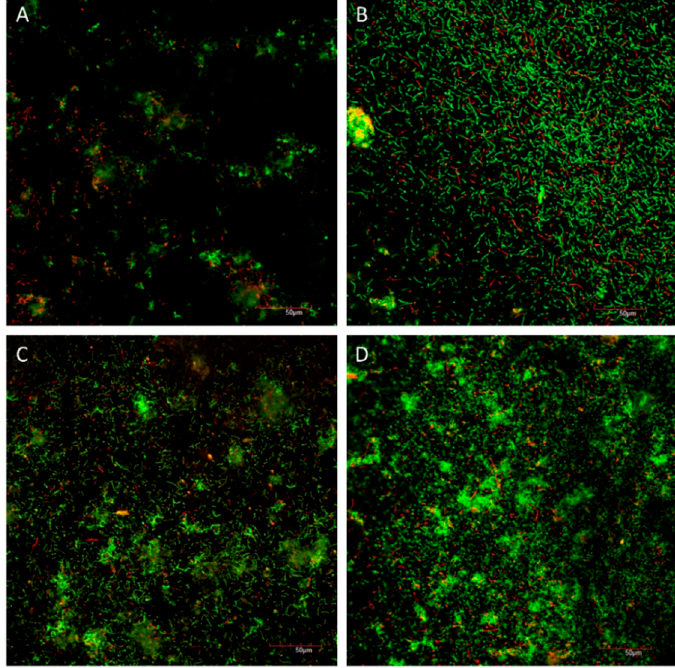
Figure 4. SEM images of biofilm of different groups on dentine surface after 48 h (×1000). ( A ) PDA + PEG; ( B ) PEG; ( C ) PDA; ( D ) Water (PDA: polydopamine, PEG: polyethylene glycol).